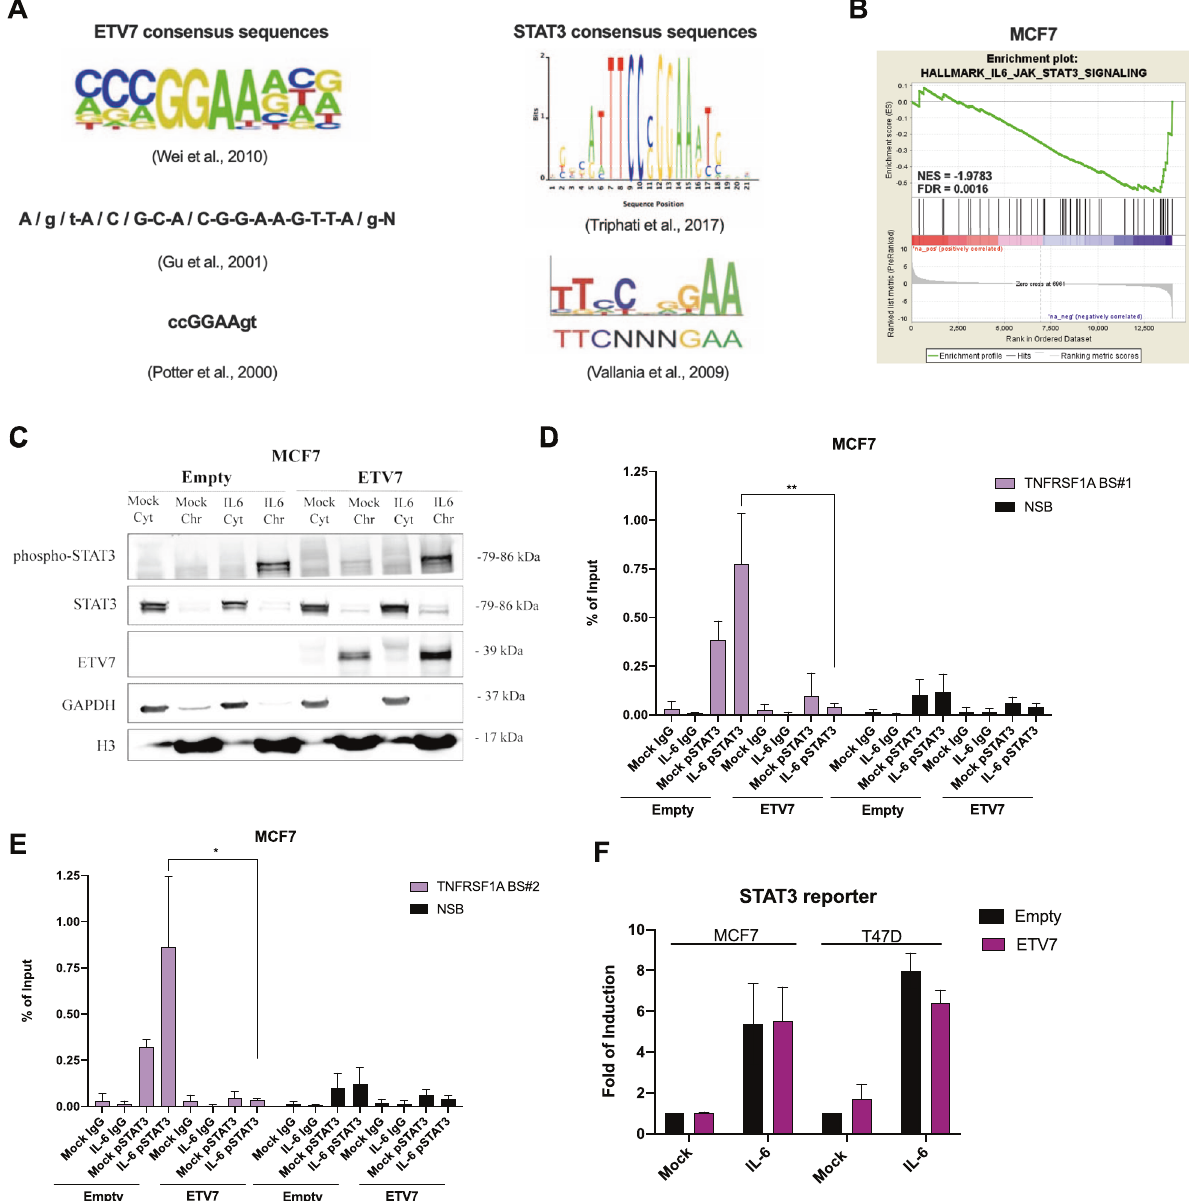
Fig. 5 Crosstalk between ETV7 and STAT3. A Canonical ETV7 and STAT3 binding sites known from the literature. B Gene Set Enrichment Analysis of MCF7 cells over-expressing ETV7 or its Empty counterpart. Enrichment plot for IL6_JAK_STAT3 signaling in MCF7 cells gene sets of the Hallmark Collection. The Normalized Enrichment Score (NES) shows the degree of the enrichment of the gene set; the negative sign indicates that the gene set is down-regulated in cells over-expressing ETV7. FDR = False Discovery Rate. C Western blot analysis of subcellular fractionation from MCF7 Empty and MCF7 ETV7 cells untreated or treated with IL-6 (20 ng/ml) for 4 h. On the right of each blot is indicated the approximate observed molecular weight. Cyt — cytoplasmic protein fraction, Chr — chromatin-enriched protein fraction. GAPDH was used as a loading control for the cytoplasmic fraction. Histone H3 was used as a loading control for chromatin-enriched protein fraction. D , E ChIP-qPCR of TNSFRSF1A Intron 1 Binding site #1 ( D ) and Binding site #2 ( E ) in MCF7 cells over-expressing ETV7 untreated or treated with IL-6 (20 ng/ml) for 4 h. The percentage of the enrichment of pSTAT3 or control (normal rabbit IgG) bound to TNFRSF1A Intron 1 with respect to Input DNA is shown. NSB — non-speci fi c binding, a region within the ACTB promoter. BS — binding site. Bars represent the averages and standard deviations of at least three biological replicates. F) Gene reporter assays in MCF7 Empty/ETV7 (on the left) and T47D Empty/ETV7 (on the right) cells transfected with M67-STAT3 reporter untreated or treated with IL-6 (20 ng/ml) for 4 h. Data are normalized using the Renilla reniformis luciferase reporter vector pRL-SV40 and shown as fold of induction relative to the Empty untreated control. Whole panel: * p ≤ 0.05; ** p ≤ 0.01; *** p ≤